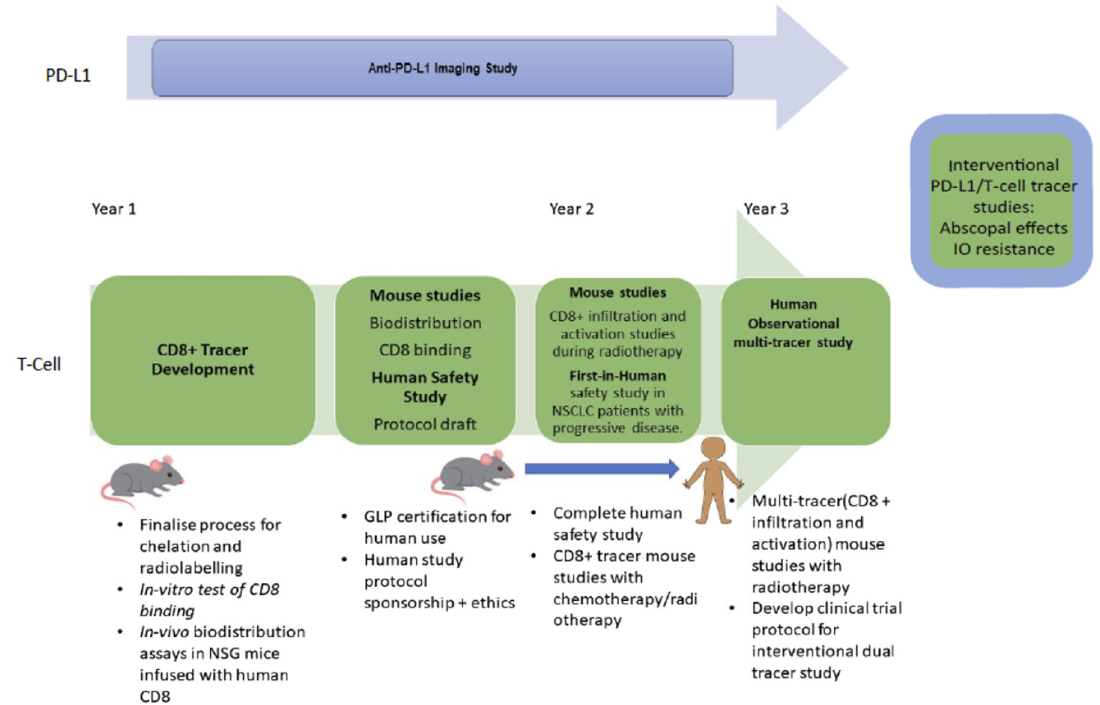
Fig. 4 Development of a putative novel tracer. Novel tracer development of a putative CD8 tracer, based on small-antibody alternatives, which could then be integrated with existing tracers to image activated CD-8 cells, such as 18 F- arabino-furanosylguanine (ARA-G). Combination studies with T-cell tracers and tracers for PD-L1/PD-1 such as adnectin 18 F-18F-BMS-986192 could help determine the causes of immunotherapy resistance in patients on ICI, as well as being used to investigate the mechanisms of therapeutic strategies such as induction of abscopal effects after